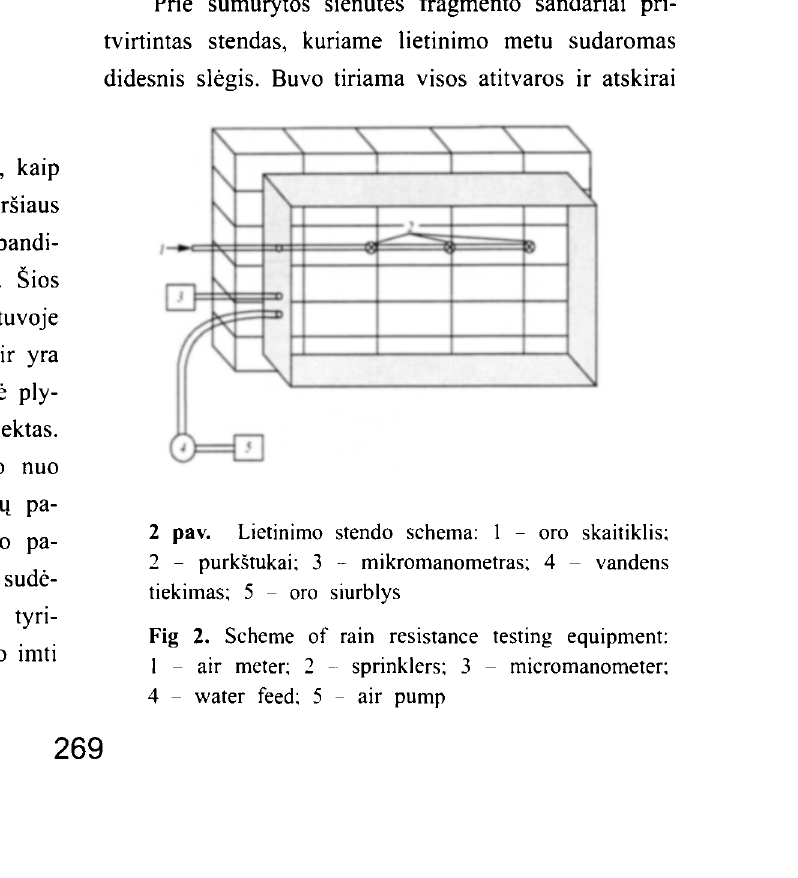
Fig 1. Scheme of a wind movement around a house Todel, net ir nesmarkiai lyjant, sienos pakrasciuose 1r virsuje krituliq kiekis iki 3 kartq virsija krituliq kieki, tenkanti centrinei sienos daliai, del to siena ga li pasidengti istisine vandens plevele [2].